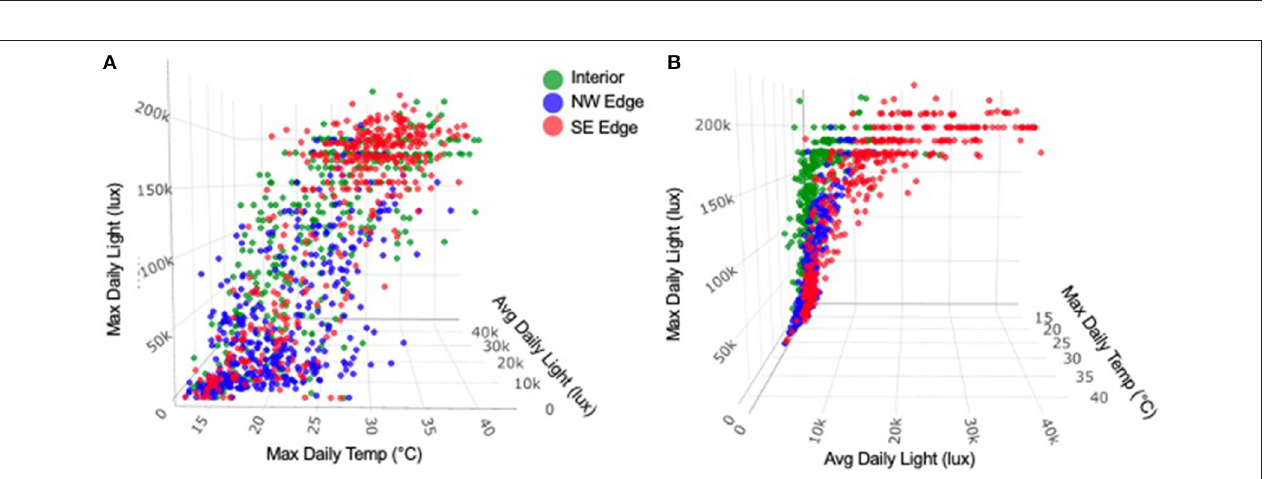
FIGURE 6 | Magnitude and direction of significant pairwise differences ( Table 2 ) across three locations in the groves, SE, NW, and interior (pooling NE and SW and Aggregation) are shown on the ordinate (the location of the pair with the greatest absolute value is shown by the “ < ” symbol. Tests account for blocking between groves and temporal autocorrelation of the data. All significant pairwise differences were between the interior grove locations (collectively) and one but not both edges, or between the two edges, and for MaDT, ADL, and MaDL.